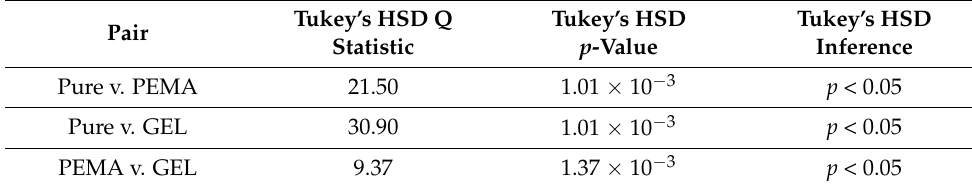
Table 6. Tukey’s statistical analysis for the measurement pairs, for Pure, PEMA and GEL samples 24 h after initial scratches.